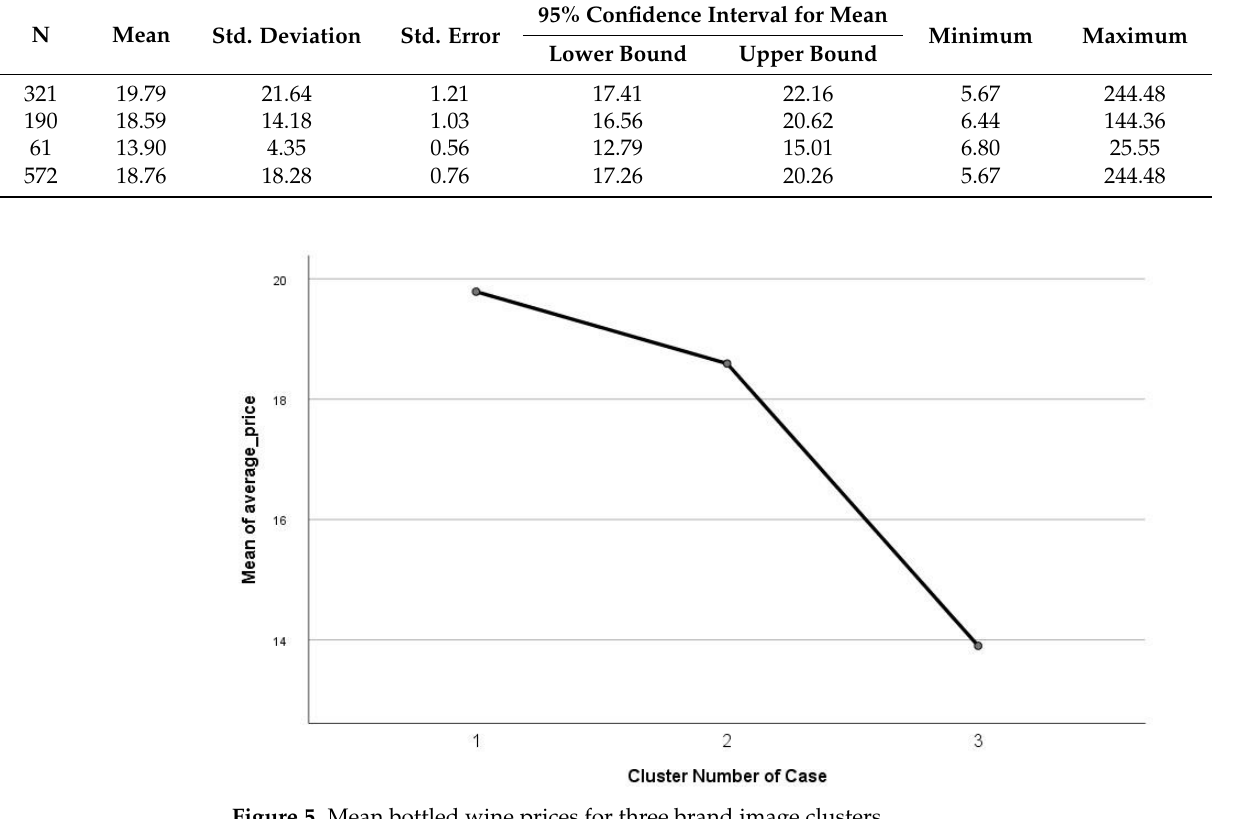
Figure 5. Mean bottled wine prices for three brand image clusters.